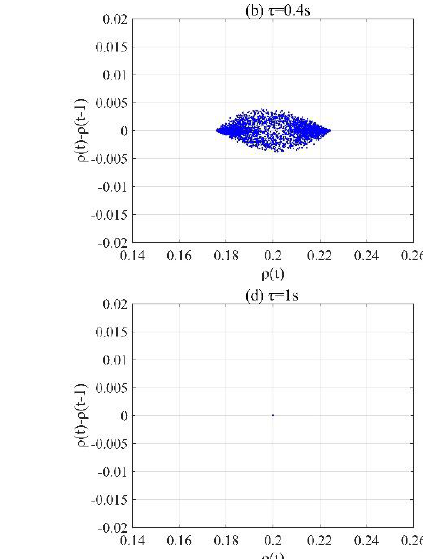
Figure 8. Density profile at 10300 t s = corresponding to Figure 7.